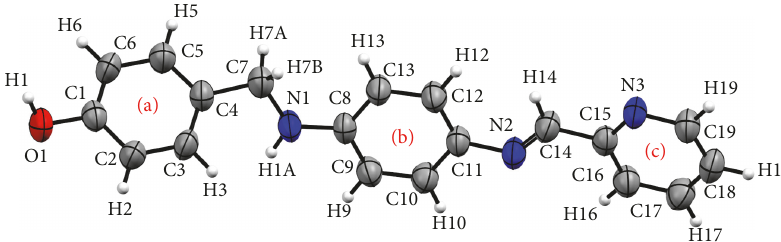
Figure 1: A view of the EPAF molecule showing the atom labeling